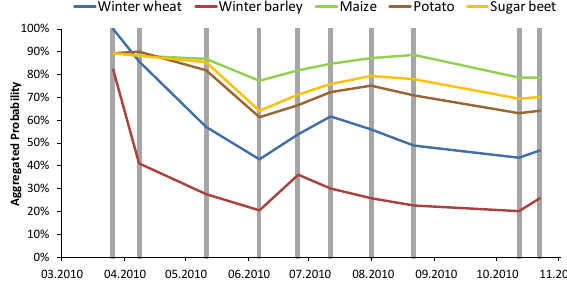
Figure 9. Aggregated probabilities for all modelled crop types of one maize pixel over the whole growing season of 2010. Grey vertical lines indicate satellite acquisitions.